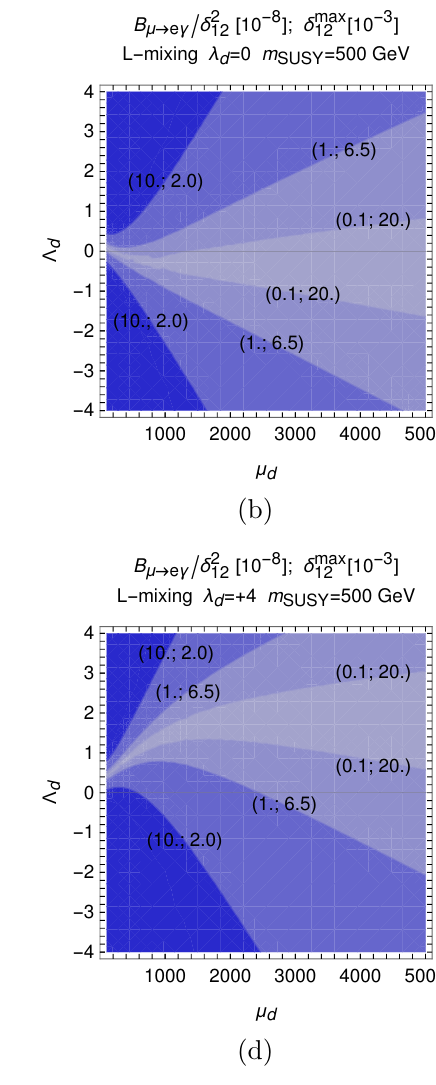
Figure 9. (cid:22) e(cid:13) in the equal-mass scenario, with (cid:22) d kept as a free parameter. In plot (a) only (cid:14) R ! is nonzero, while (cid:14) L = 0; opposite in plots (b,c,d). The values of (cid:3) d ; (cid:21) d are indicated in the plots. 12 2 and on the other hand to the maximum The contours correspond on the one hand to B (cid:22) e(cid:13) = ( (cid:14) 12 ) ! (cid:14) 12 allowed by the MEG limit. See eqs. (4.24), (4.25) for an approximation of the behaviour. arising from the new form factors. Not all parameters lead to a nontrivial